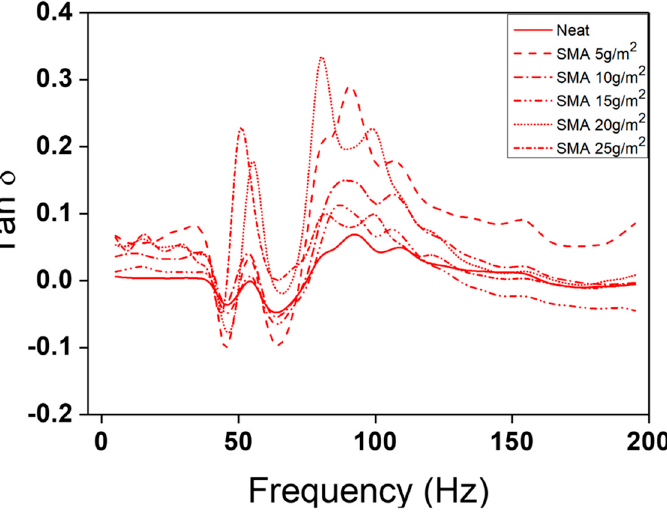
Figure 7. SEM images of fracture surfaces of the CFRP specimens with PZT specimens with different particle loadings.